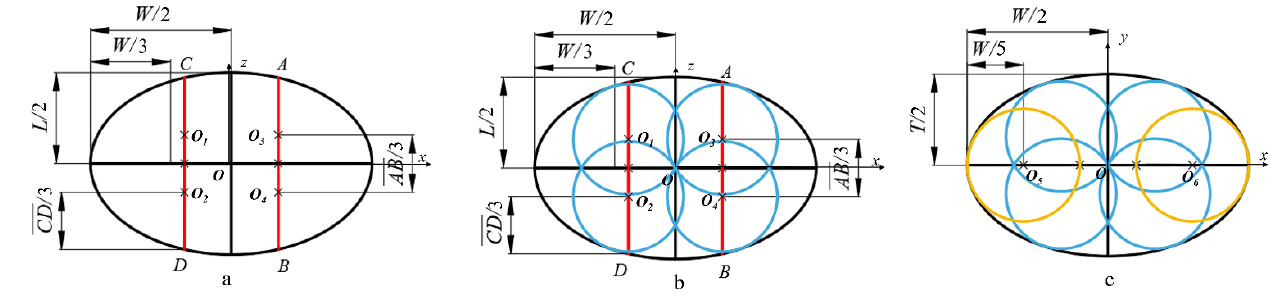
Figure 13. ( a – c ) Filing methods for the multi-sphere model of Jinong 3. In addition, on the xoy plane, the width W of the ellipsoid was divided into five parts, and the equal diversion points (point O 5 and point O 6 ) were only considered as the centers of the new filing spheres. Thus, another two spheres that were tangential to the outline of the ellipsoid were filled, defined as sphere O 5 and sphere O 6 , as shown in Figure 13c. Finally, the last sphere O 7 was filled at the position of the hilum. As a result, seven total spheres were filled. Based on the filing principle, 7-sphere, 9-sphere, and 11-sphere models of Jinong 3 were successively modeled, as shown in Figure